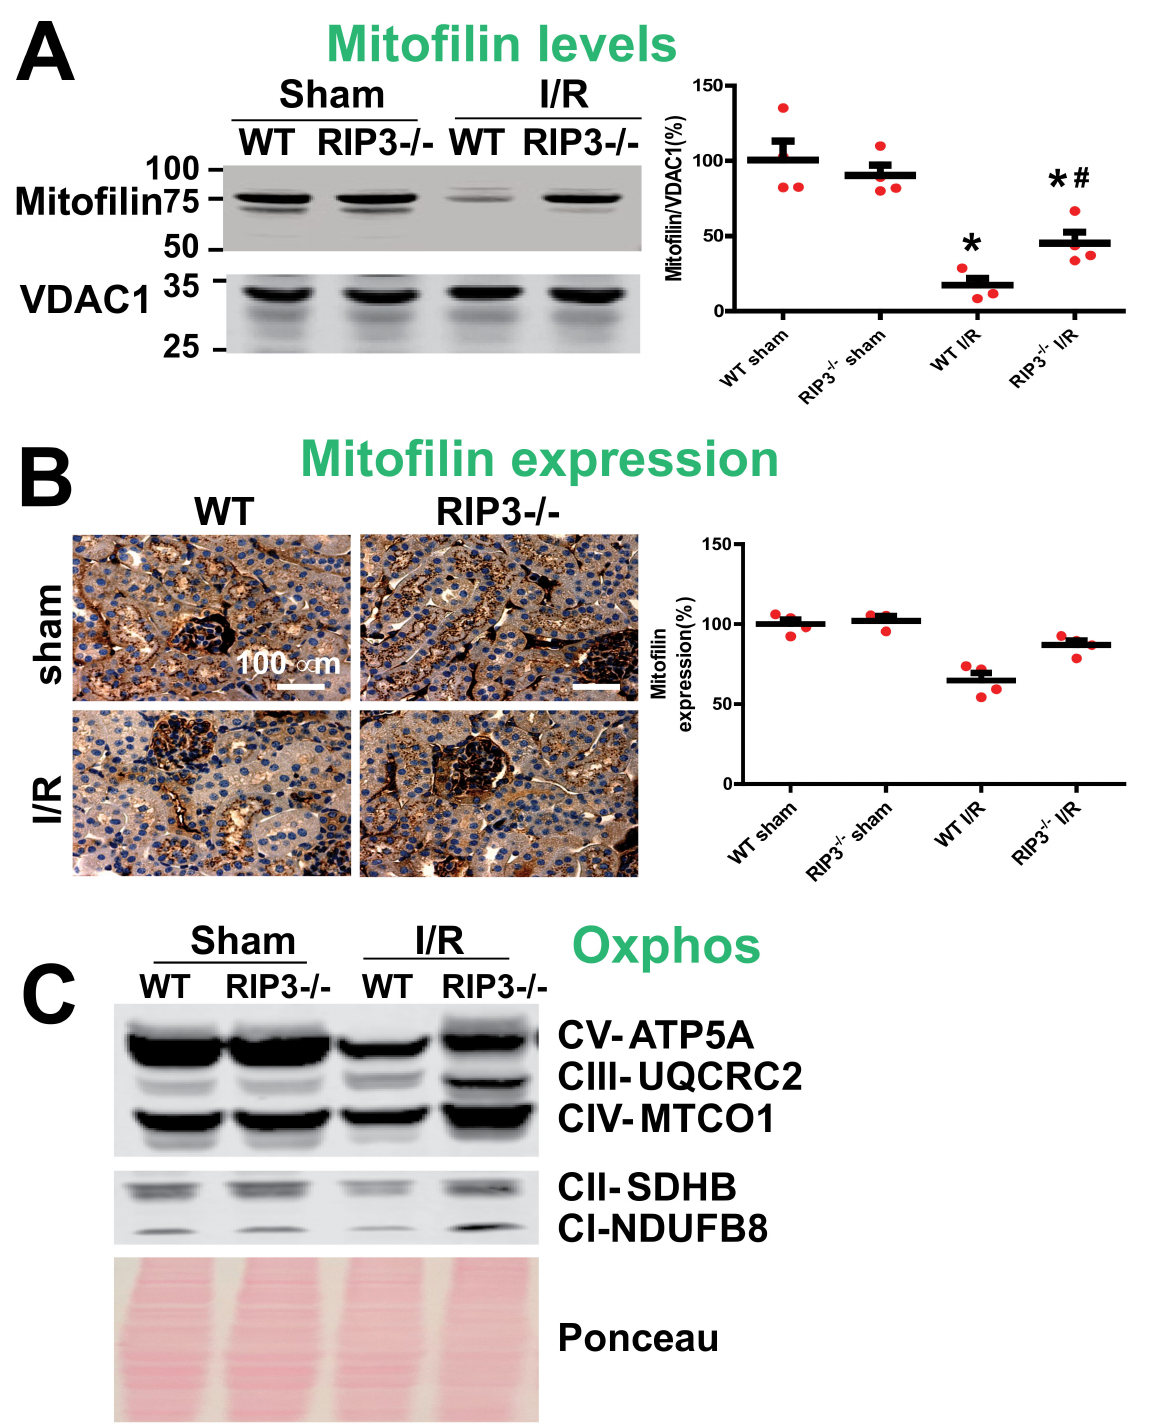
Figure 4. Preservation of Mitofilin in RIP3 − / − mice is associated with decreased mitochondrial damage and dysfunction after renal I/R. ( A ) Immunoblots showing dramatic reductions in